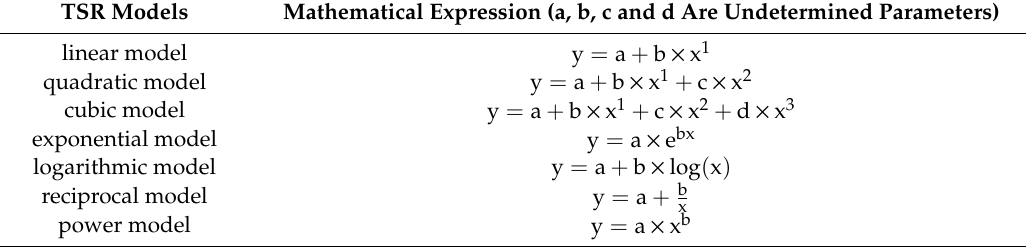
Table 1. The traditional statistical regression models. TSR